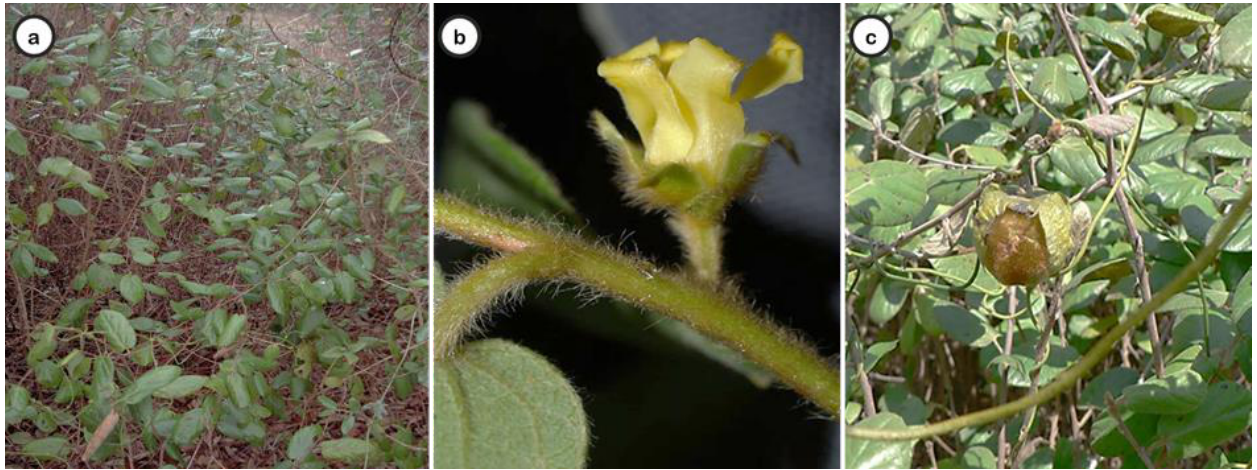
Figure 1. D. villosa in nature ( a ); detail of flower ( b ) and fruits ( c ). Photography by: Olga Silva & Elsa Gomes.